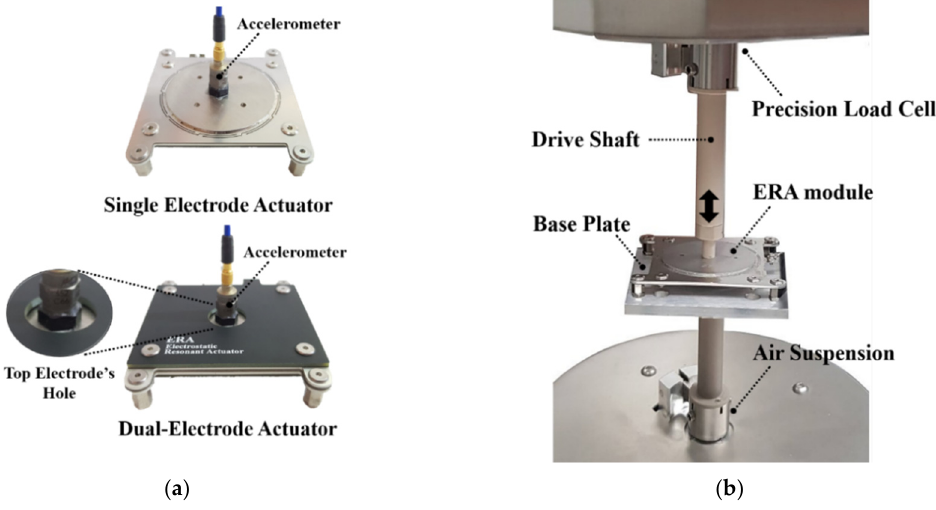
Figure 5. ( a ) Acceleration testing setup used to measure the actuator’s damping ratio; ( b ) dynamic mechanical analyzer (DMA) testing setup used to measure the actuator’s spring stiffness.